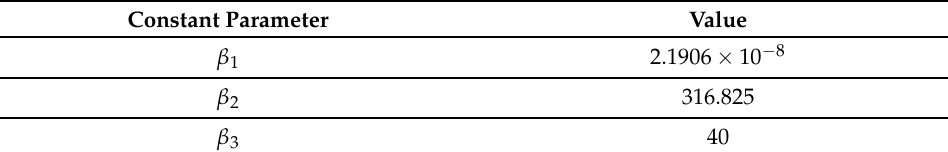
Table 1. Constant parameters in Q H